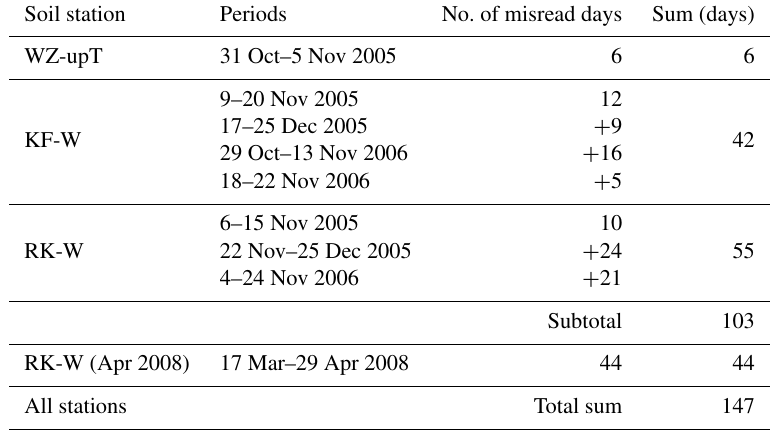
Table B1. Days with misreadings.